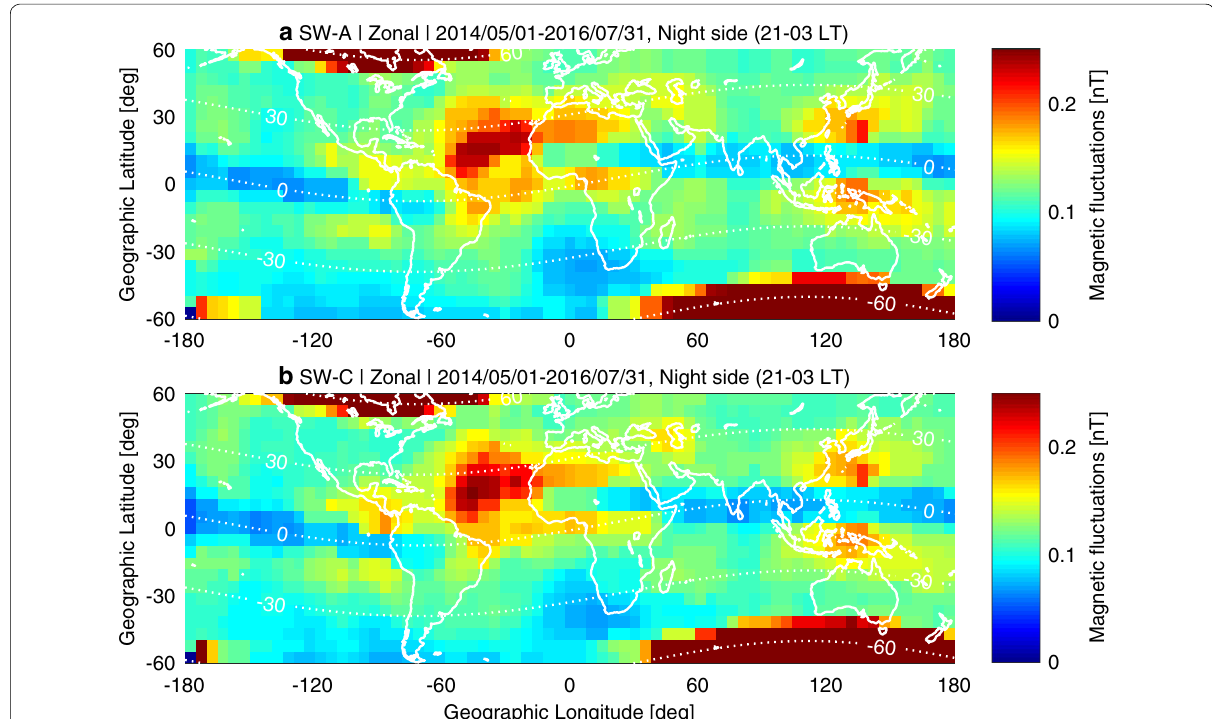
Fig. 5 Global distributions of the MR amplitudes of the zonal component on the night side (21–3 LT) observed by a SW-A and b SW-C within